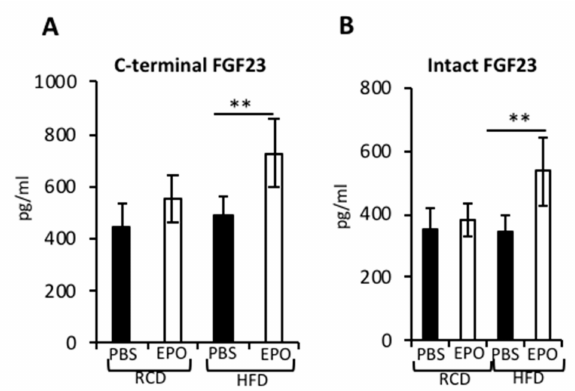
Figure 6. EPO-induced serum FGF23 in HFD-fed mice. ( A , B ) The serum levels of FGF23 measured using ELISA assays, ( A ) c-terminal FGF23 and ( B ) intact FGF23. ( n = 3–6 / group). * p <